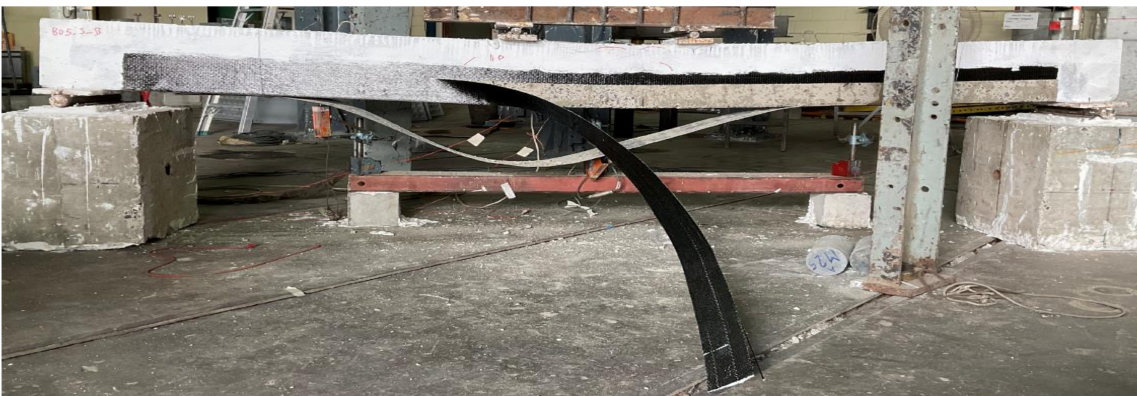
Figure 15. Typical CFRP rupture observed in the 3rd group.